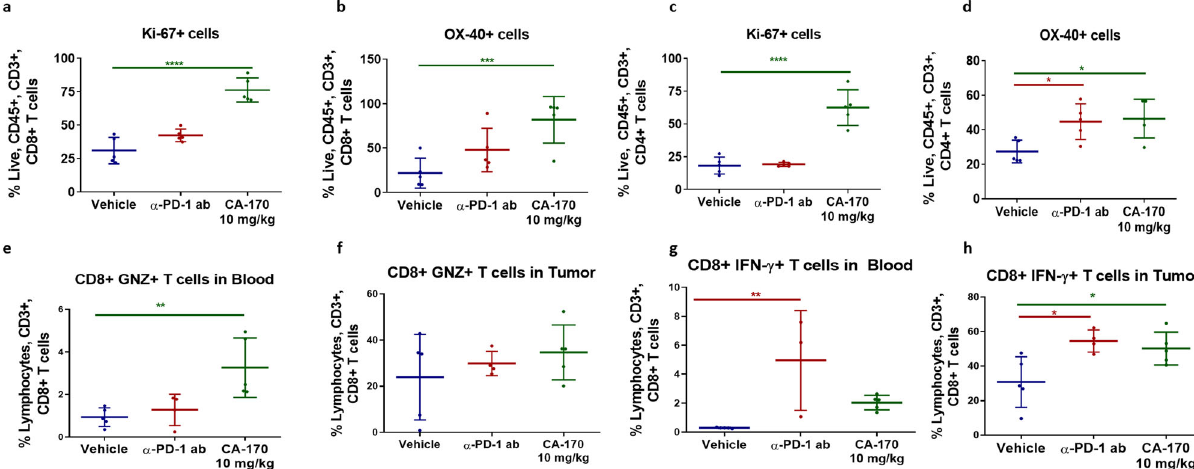
Fig. 4 Immune PD of CA-170 in CT26 colon carcinoma model. CT26 tumor bearing mice were dosed with CA-170 at 10 mg/kg daily along with a vehicle control and a PD-1 antibody control (J43 Clone, 100 µ g/animal) ( n = 5). After 5 days of dosing the tumor in fi ltrating lymphocytes were labeled with Ki67 as a measure of proliferation and OX-40 as an indicator of T-cell activation. a – b Increase in the proliferating and activated CD8 + T cells. c – d Increase in the proliferating and activated CD4 + T cells. e – f Increase in granzyme B and g – h IFN- γ secreting CD8 + T cells in blood and tumor of MC38-tumor bearing mice dosed daily at 3 mg/kg for 7 days. * p < 0.05, ** p < 0.01, *** p < 0.001, **** p < 0.0001 as calculated by one-way ANOVA (Dunnett ’ s multiple comparisons